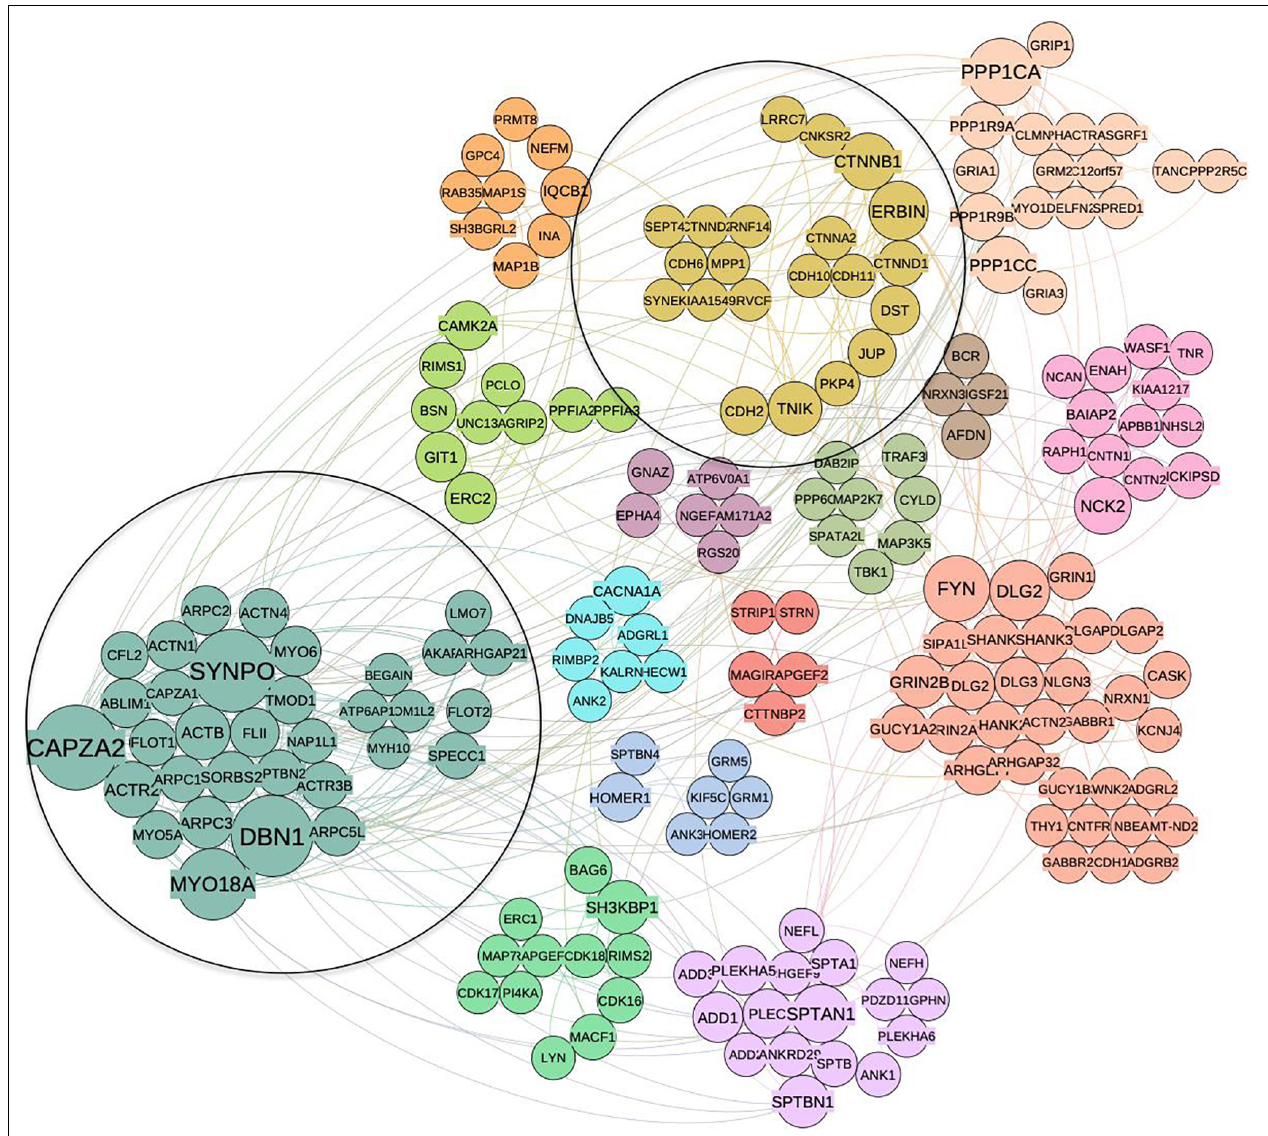
FIGURE 4 | The community structure of p140Cap network in the synaptic compartment and the overlap with cancer set. Similar as for cancer network, distinct communities are highlighted by different colors. Two communities overlapping with cancer network are circled.